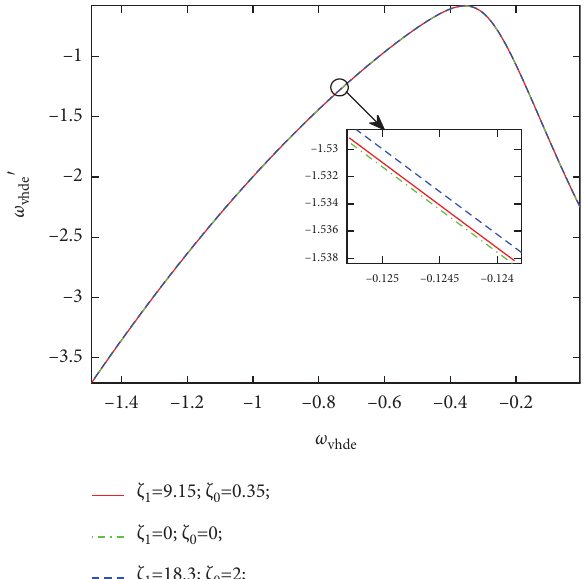
Figure 21: EoS plane ( ω